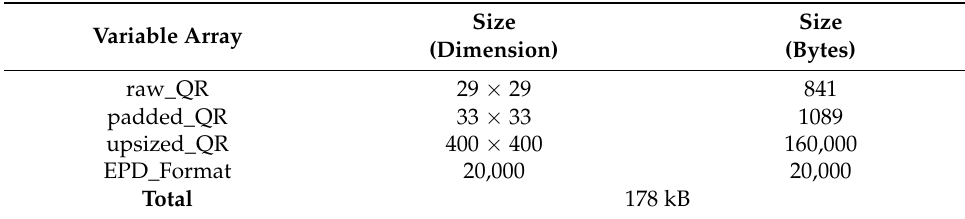
Table 1. Memory calculation.